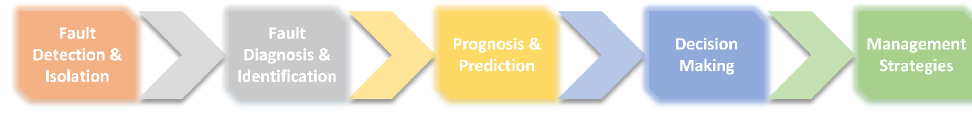
Figure 1. Basic tasks involved in a typical PHM